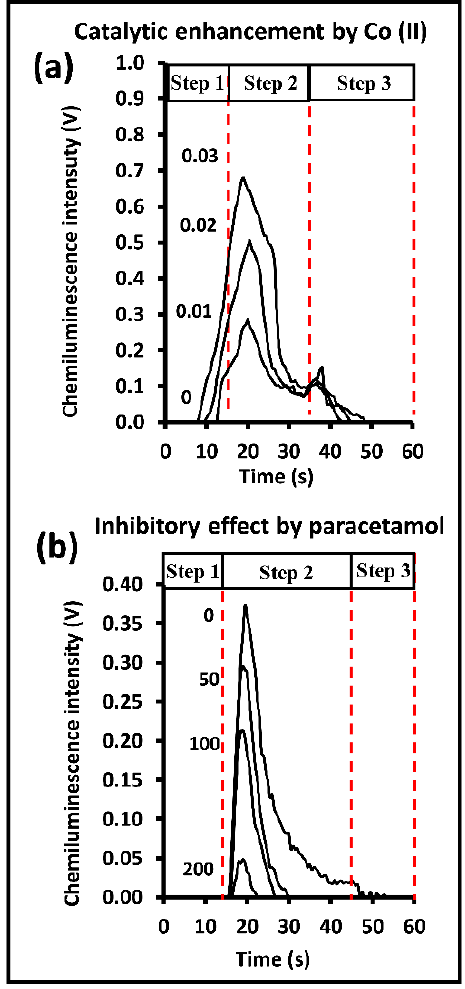
Figure 2. Examples of chemiluminescence signal profiles obtained from the CIA flow manifolds in Supplementary Material Figures S1 and S3. ( a ) Catalytic enhancement of CL emission induced by three concentrations of standard solutions of Co (II) (0.01–0.03 mg L − 1 ). ( b ) Inhibitory effect induced by three concentrations of standard solutions of paracetamol (50–200 mg L − 1 ).